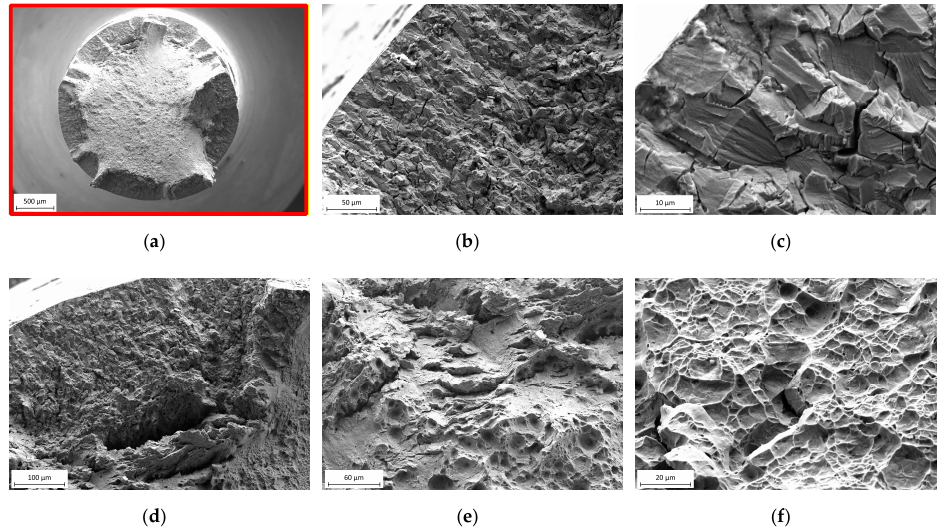
Figure 6. Fracture surface of the 10 mA/cm 2 in-situ hydrogen charged SSRT at room temperature: ( a ) markedly reduced reduction in area and visible cracks from the surface to the centre, ( b ) hydrogen induced cracking at the edge of the sample, ( c ) transgranular cracking with minor amounts of intergranular cracks, ( d ) transitions from the hydrogen induced cracking to a more ductile part in the centre of the sample, ( e ) transition zone between hydrogen induced cracking and ductile fracture with some dimples, ( f ) flat dimples in the centre of the sample.